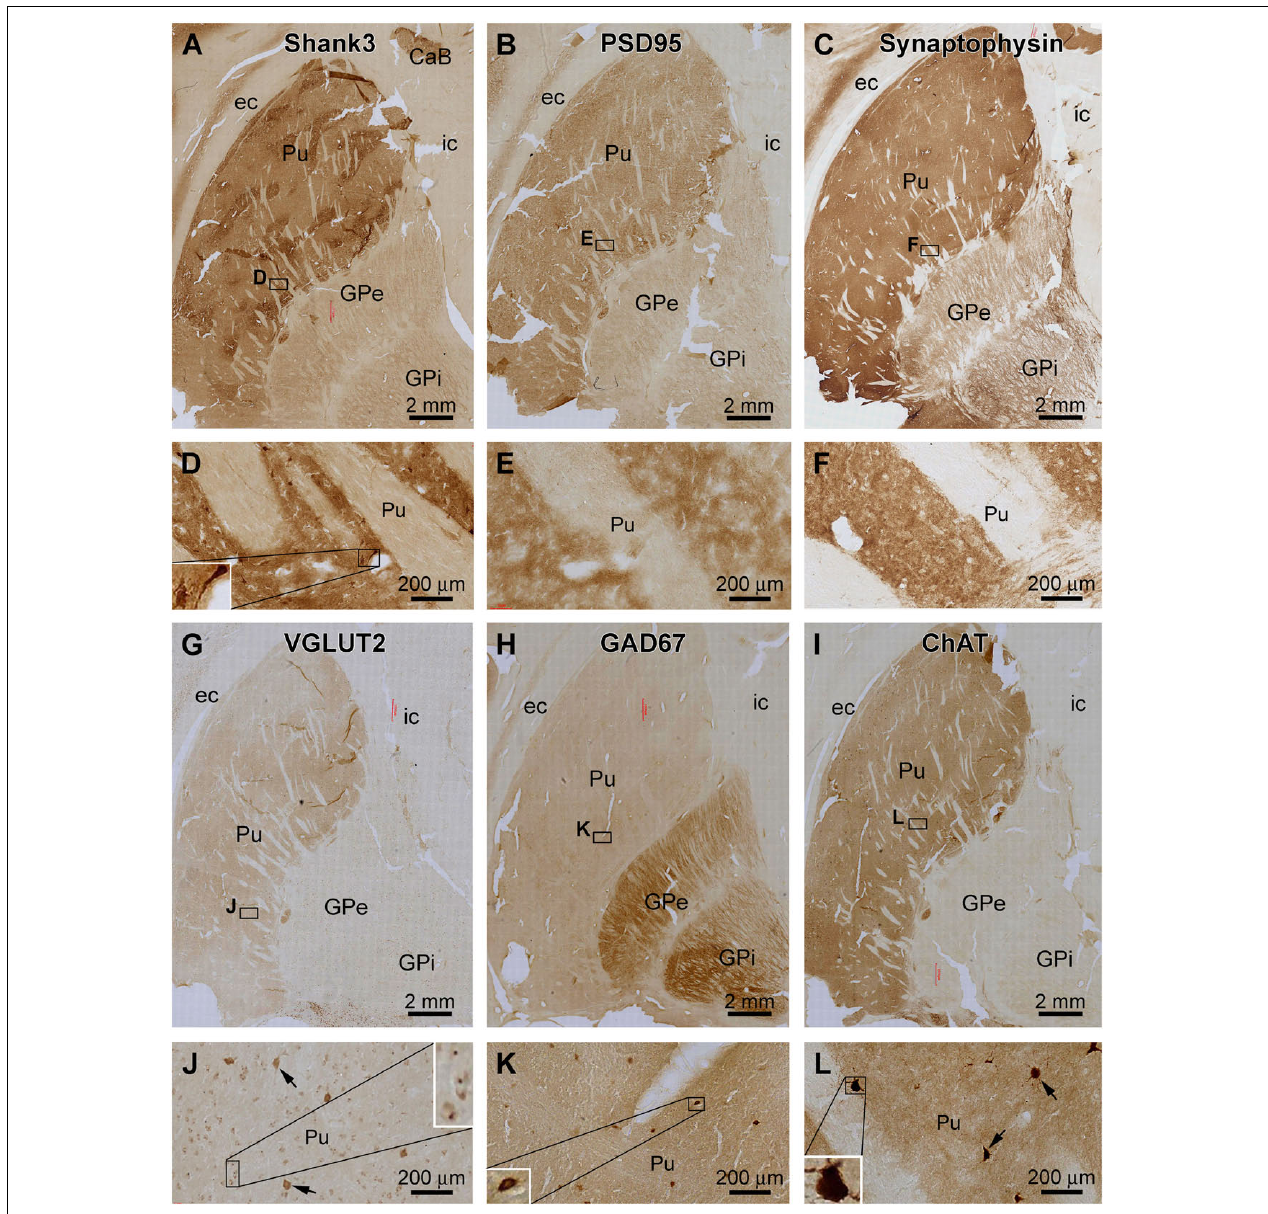
FIGURE 6 | Comparative assessment of Shank3 IR relative to that of general synaptic markers and specific neuronal markers in the striatum. Low power views on the putamen (Pu) and globulus pallidum (GP) and enlarged areas are as indicated. The overall intensity of Shank3 (A,D) , postsynaptic density protein 95 (PSD95, B,E ), synaptophysin (C,F) , vesicular glutamate transport 2 (VGLUT2, G,J ), and choline acetyltransferase (ChAT, I,L ) IR are heavier in the Pu than the GP. In contrast, the intensity of the glutamate decarboxylase 67 (GAD67) IR is greater in the GP than the Pu (H,K) . Besides neuropil reactivity, Shank3, VGLUT2, and ChAT IR occur in a population of large-sized multipolar neurons (D,J,L) , whereas GAD67 IR marks relatively small-sized neurons in round, oval or bipolar shape (H) . Punctate profiles of VGLUT2 IR are seen around the small-sized neurons in the Pu (J) . Abbreviations are as defined in Figure 5 . Scale bars are as indicated in each